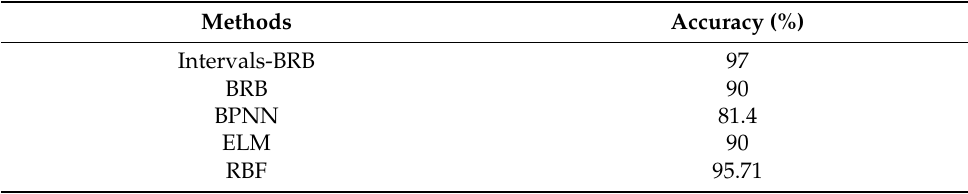
Table 15. The accuracy of different